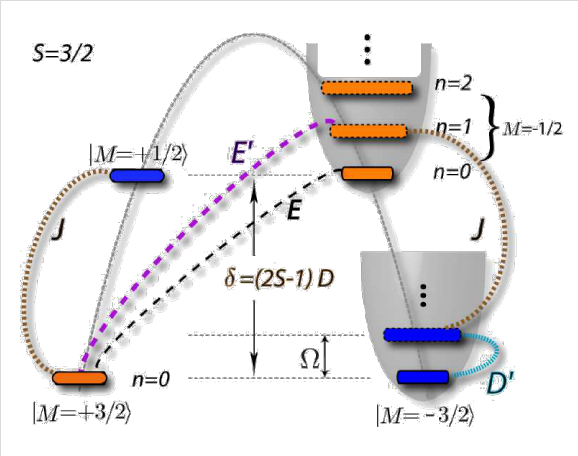
Figure 1: Magneto-mechanical excitation spectrum of the SMM with S = 3/2. Magnetic states, lying on an inverted parabola due to the static longitudinal anisotropy ( D ), each have vibrational excitations ( n ) on the upright parabolas. Magnetic transitions induced by Kondo spin- scattering ( J ), static anisotropy ( E ) and longitudinal ( D ′ ) and trans- verse ( E ′ ) spin-vibration coupling are indicated. Magnetic states in the two different Kramers' subspaces are marked blue and